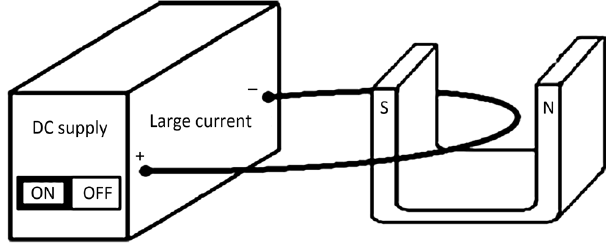
FIG. 3. Experiment 3: demonstrating magnetic force on a current-carrying wire. The current-carrying wire jumped up or down, depending on the orientation of the magnet, when the current was switched on.